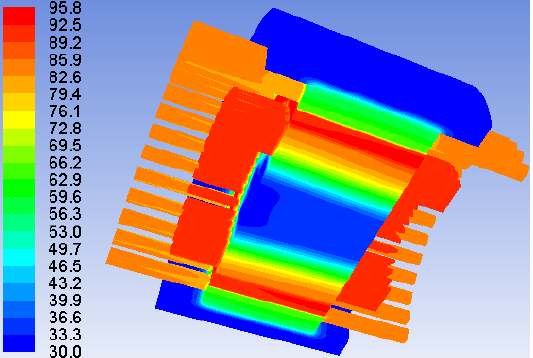
Figure 15. Thermal field distribution under condition of water cooling used in the casing and the inner rotor when both the SM and the DRM are running at the rated speed and rated